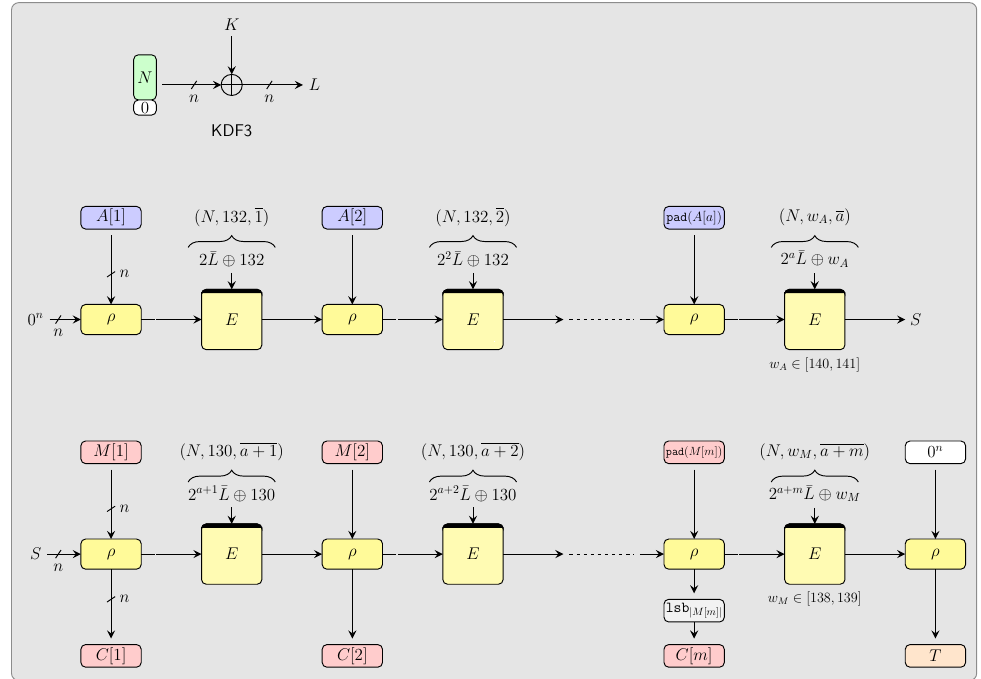
Figure 9: Remus-N with ICE3 ( Remus - N 3). (Top) Key derivation